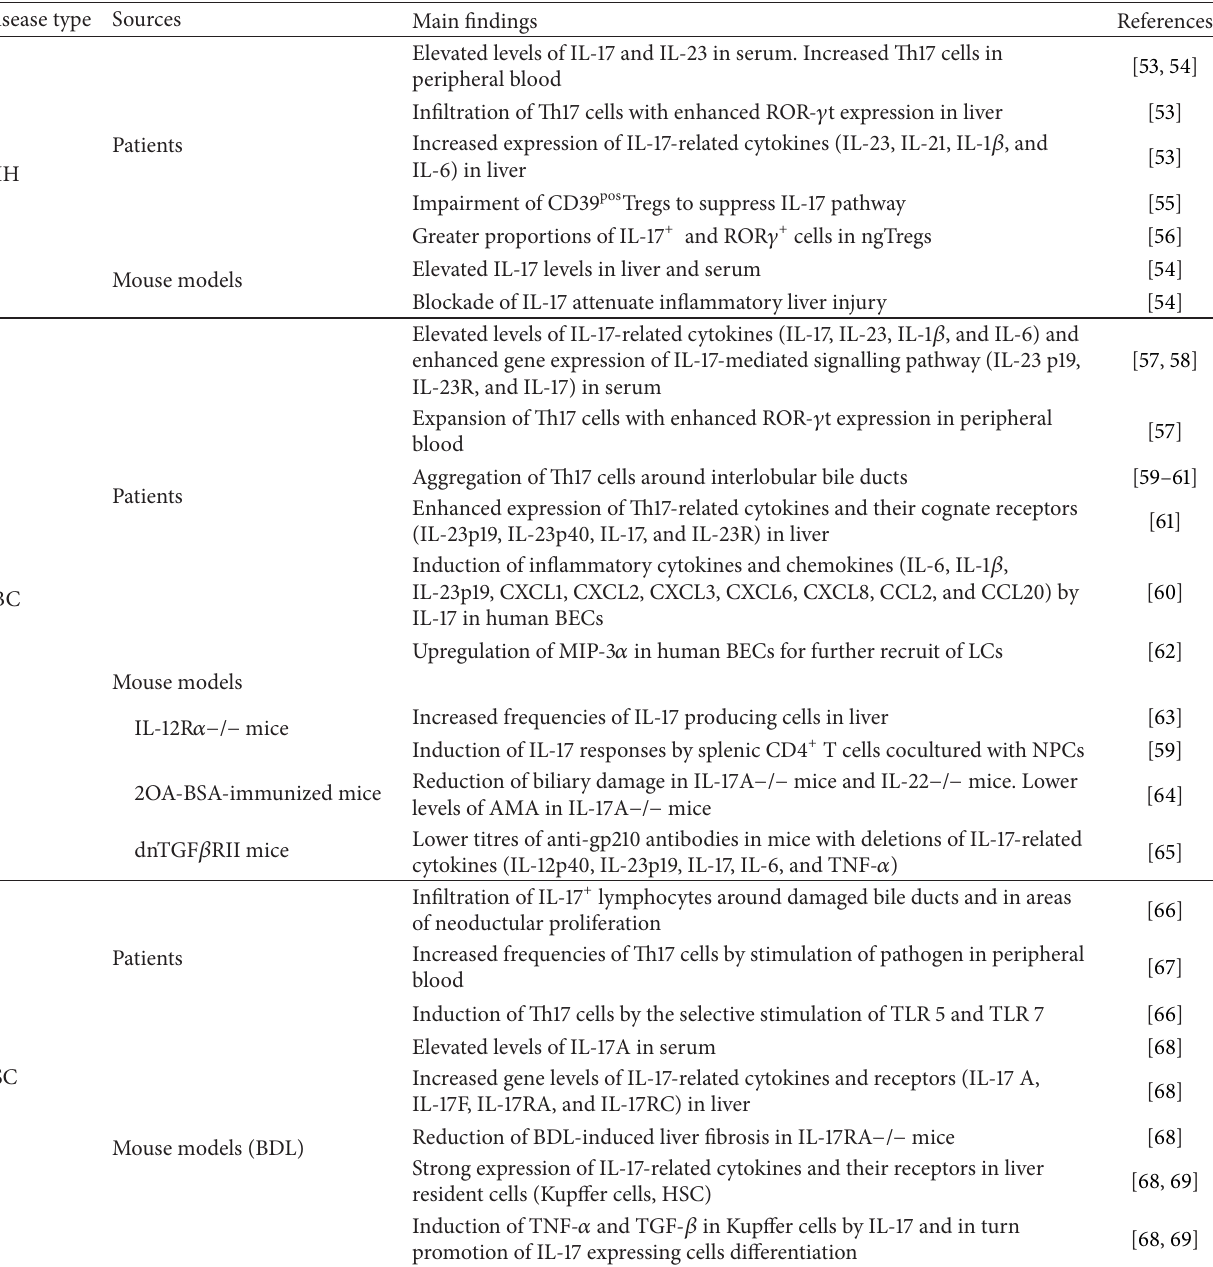
Table 1: Pathophysiological findings on IL-17 pathway in the development of AILD. Disease type Sources Main